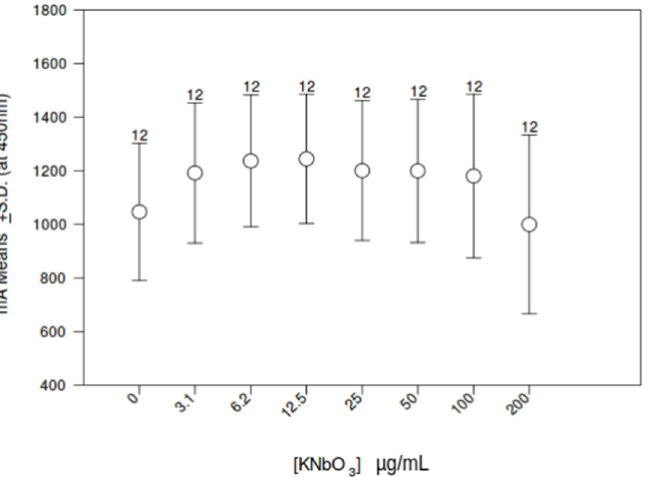
Figure 6. Metabolic activity of THP-1 cells exposed to various concentrations of KNbO 3 determined by WST-1 assay.